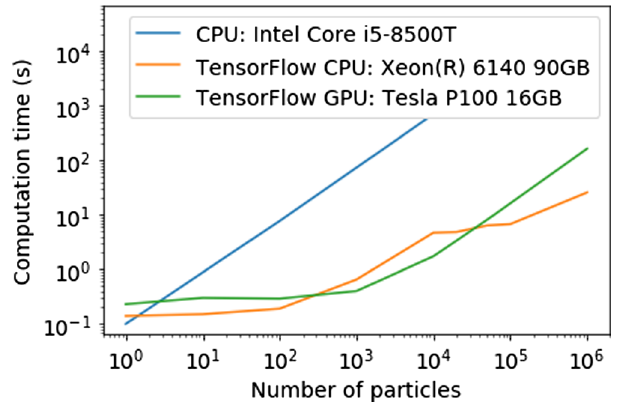
FIG. 4. Scaling of the computation time of the TM-PNN for one-turn tracking in PETRAIII lattice.